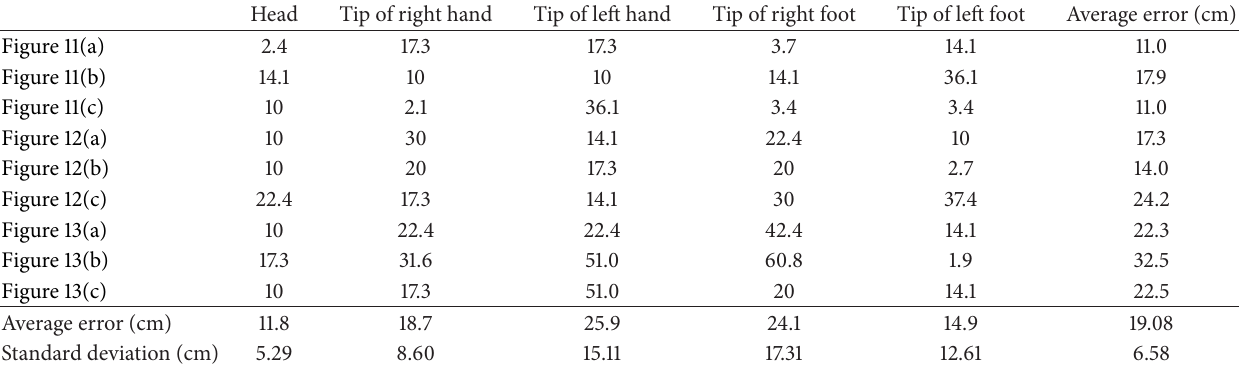
Figure 13: Experimental results of sitting and lying postures in Experiment 4, where notations of the points are the same as those in Figure 11. Table 1: The localization errors (cm) Of different significant points in Experiments